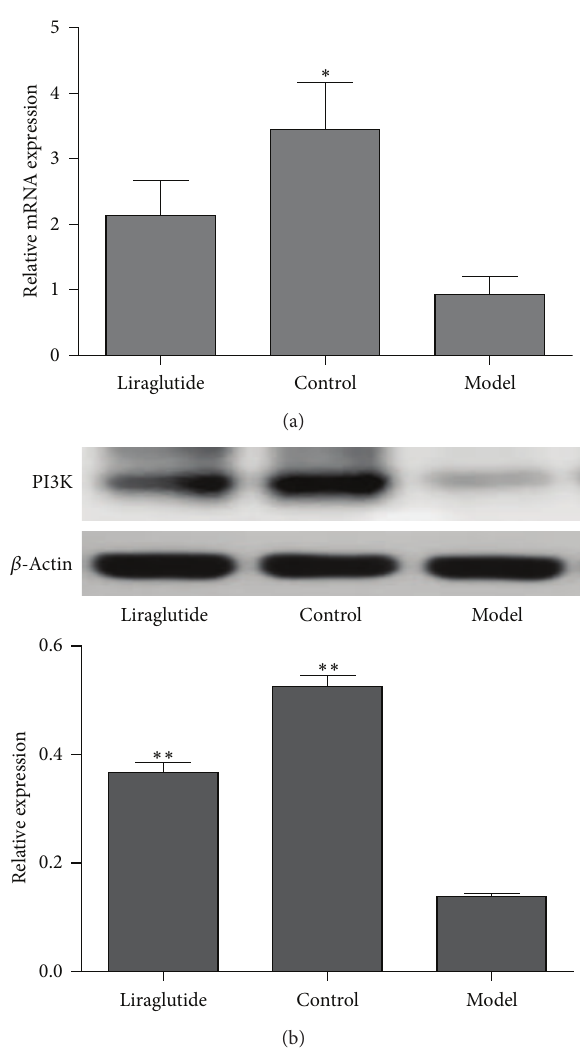
Figure 5: Effects of liraglutide on PI3K expression in skeletal muscle. (a) Expression in skeletal muscle of PI3K mRNA in normal, model, or liraglutide group. Gene expression was measured by real- time PCR. Relative PI3K mRNA abundance was normalized by 𝛽 - actin. Data were shown as mean ± SEM, ∗ 𝑃 < 0.05 , ∗∗ 𝑃 < 0.01 versus model group, 𝑛 = 5 . (b) Expression of PI3K protein in skeletal muscle from normal, model, or liraglutide group. Lysates from freshly isolated skeletal muscle tissues were measured for PI3K expression by Western blot analysis. Results were shown as mean ± SEM, ∗ 𝑃 < 0.05 , ∗∗ 𝑃 < 0.01 versus model group, 𝑛 = 5